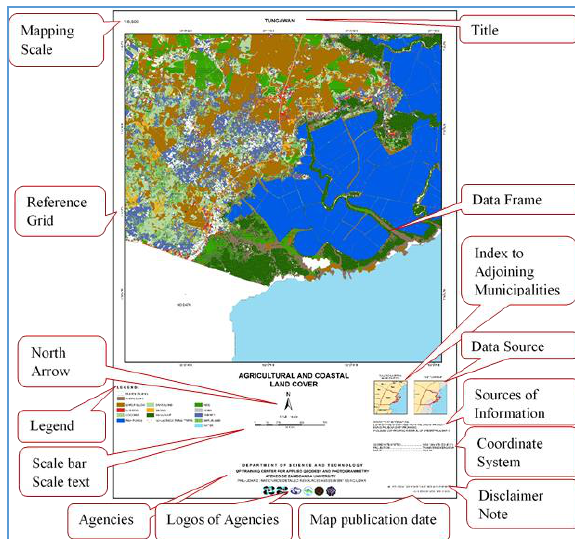
Figure 3. PARMap Template for Agricultural and Coastal Land Cover